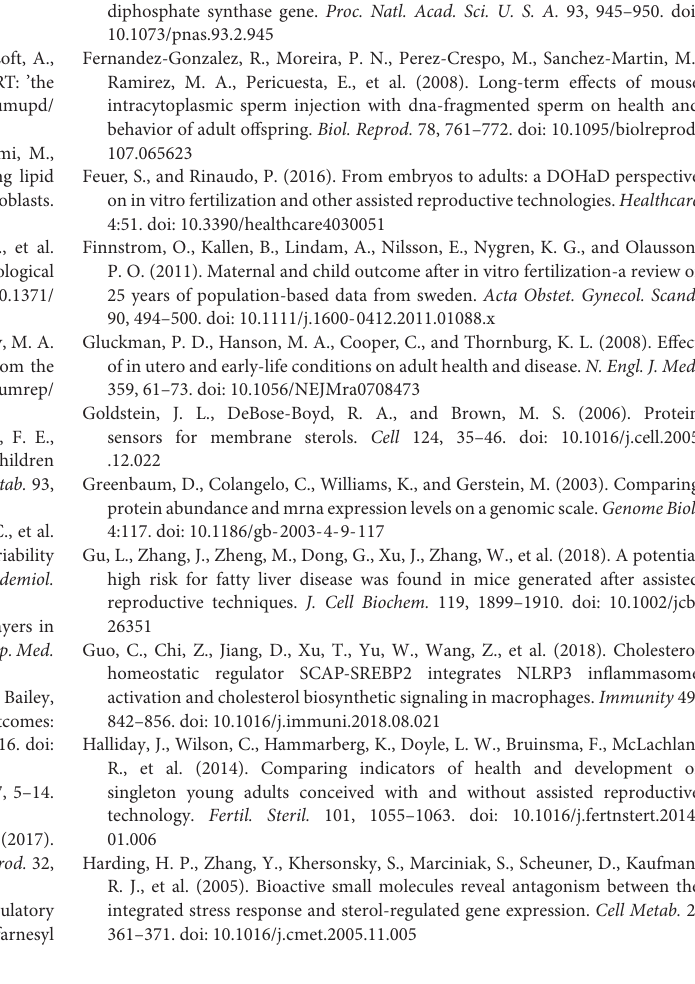
Supplementary Table 1 | The genes sequences for real-time quantitative PCR. Supplementary Table 2 | The genes sequences for BSP and